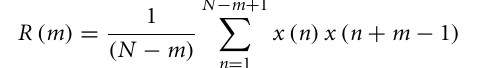
between the two tone durations at pre-and post-test. Points above the dashed gray line show an increase in the difference between DLFs while points below it show a